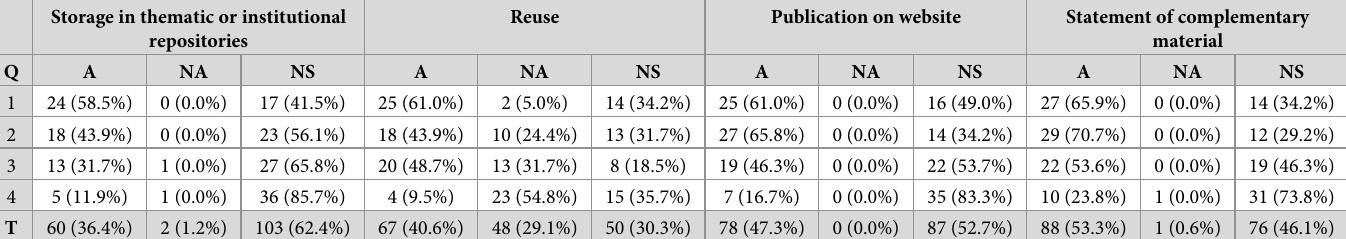
Table 1. Analysis of variables concerning the availability of articles and raw data of the 165 journals, distributed by quartiles (Q). A: Allowed; NA: not Allowed; NS: not specified; T: Total. Storage in thematic or institutional